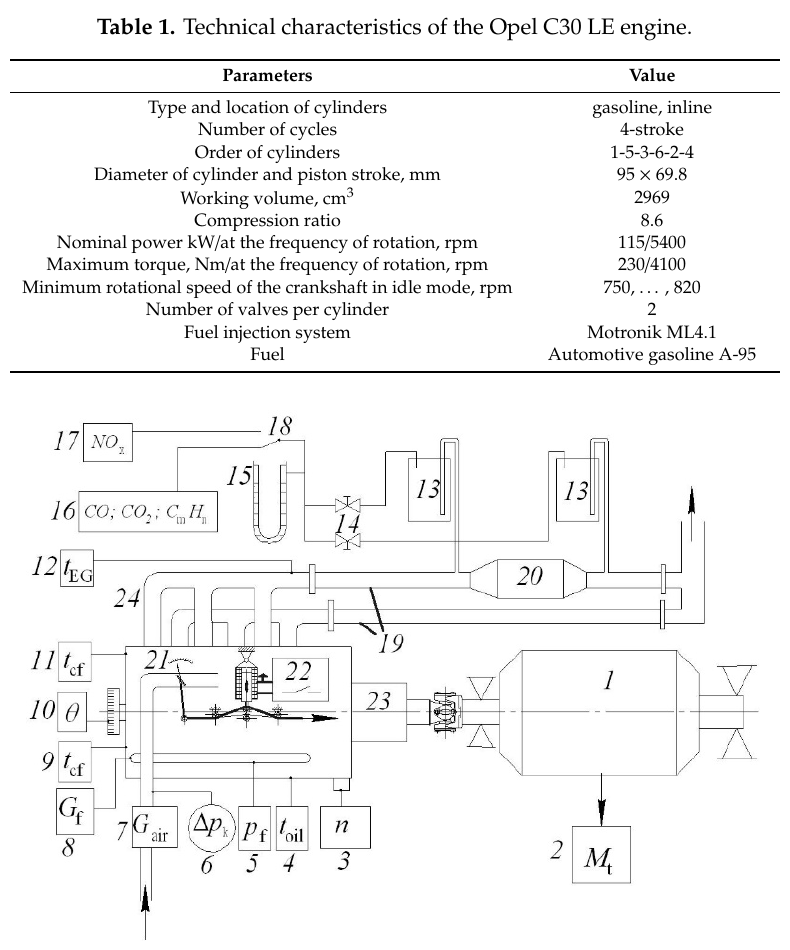
Figure 5. Schematic diagram of the experimental installation: 1—stand SGEU-100 with an electric brake AKB-92-4; 2—weighing head VKM-57; 3—device to measure the frequency of crankshaft rotation of the engine; 4—oil temperature sensor; 5—pressure sensor in the fuel line; 6—dilution sensor